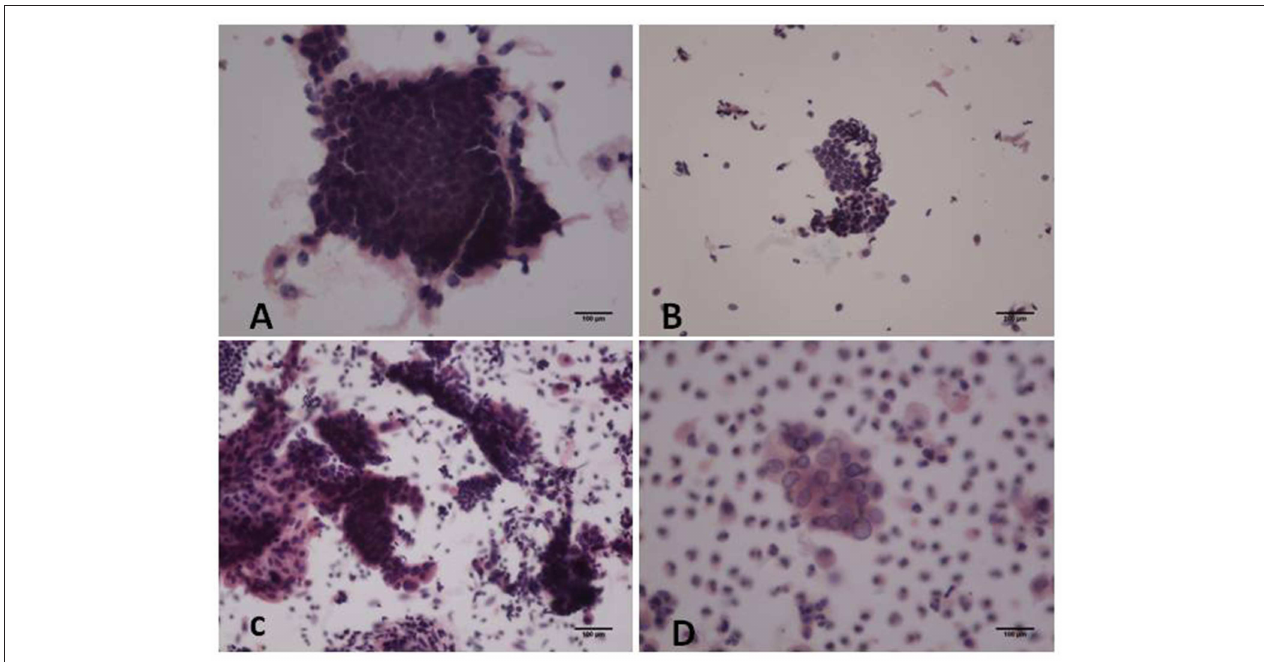
FIGURE 1 | Hematoxylin and eosin (H&E) staining of cytological samples. (A) Proliferative endometrium; (B) Atrophic endometrium; (C) Atypical hyperplasia with localized carcinogenesis; (D) Highly differentiated endometrioid carcinoma [ (A,C-D) : original magnification X200; (B) : original magnification X100].